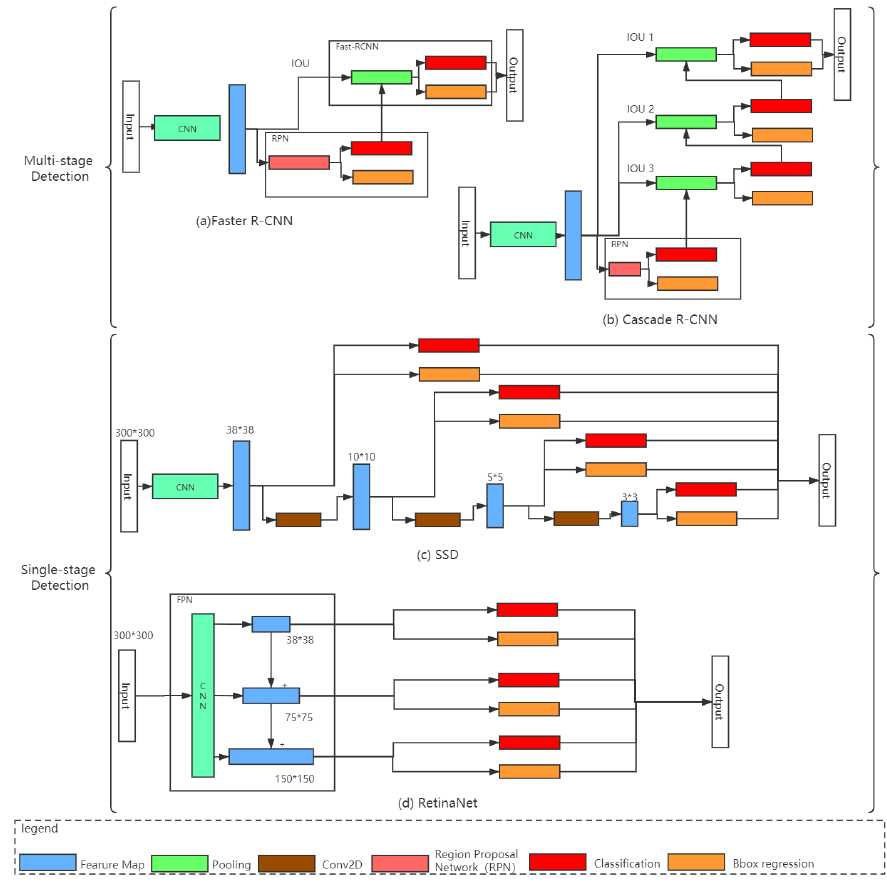
Figure 3. The architectures of four deep-learning-based object detection models: ( a ) Faster R-CNN and ( b ) cascade R-CNN are multi-stage detection models with two or more RPN modules; ( c ) SSD and ( d ) RetinaNet are single-stage detection